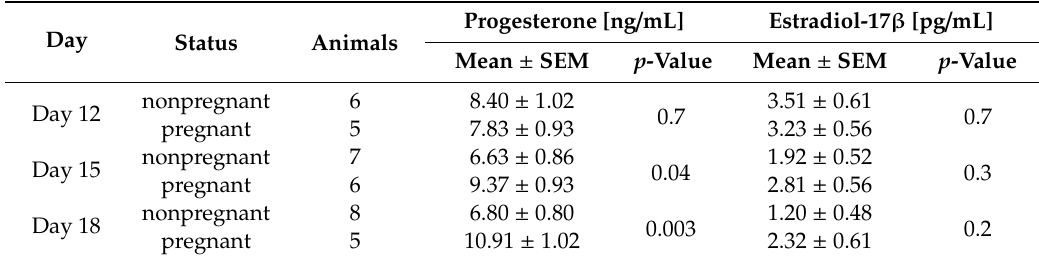
Table 1. Progesterone and estradiol-17 β concentrations at slaughter in the serum of cyclic and early pregnant heifers after insemination (insemination = Day 0). Values presented as mean ± standard error of the mean (SEM). Probability value ( p -value) for the respective pairs is